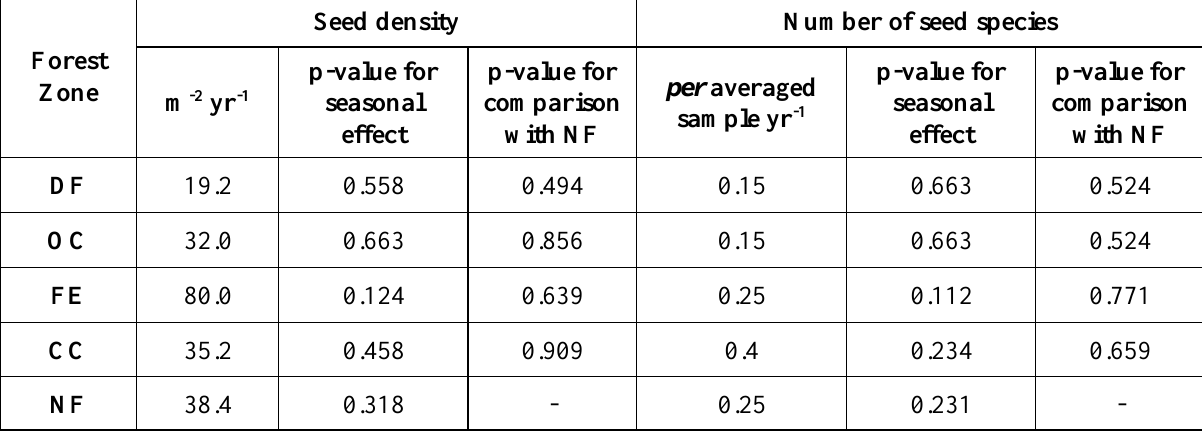
Table 1. The average annual number of seeds per m 2 and species per averaged sample. As noted in the text, no seasonal effects were detected throughout, and no significant differences from the baseline natural forest (NF) were found in any of the disturbed forest zones. See text for details of the statistical tests